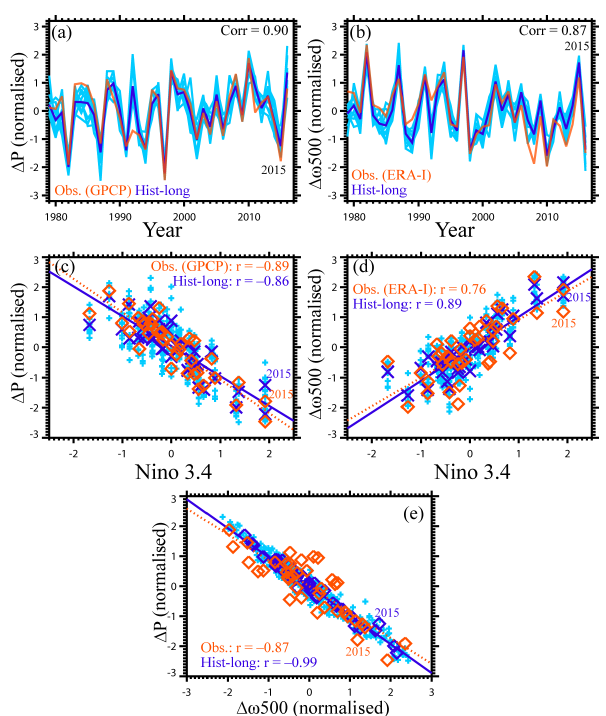
Figure 3. Evaluations of the MIROC5 simulations of the EA- averaged precipitation and vertical air motions. Panels (a) and (b) show the normalised June–November mean time series of (a) (cid:49)P (no unit) and (b) (cid:49)ω 500 (no unit). Red lines are the observations. Light blue lines are the 10 ensemble members of Hist-long, and blue lines are the ensemble mean. The other panels are scatter plots of (c) (cid:49)P and the Niño 3.4 index ( ◦ C), (d) (cid:49)ω 500 and the Niño 3.4 in- dex, and (e) (cid:49)P and (cid:49)ω 500 . Red diamonds are the observed values. Small light-blue crosses are the 10 ensemble members of Hist-long, and large blue diamonds indicate the ensemble mean values. The red and blue lines indicate the regression lines of the observations and the ensemble averages of Hist-long,